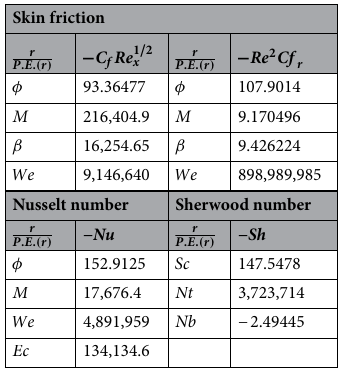
Table 8. Numerical values